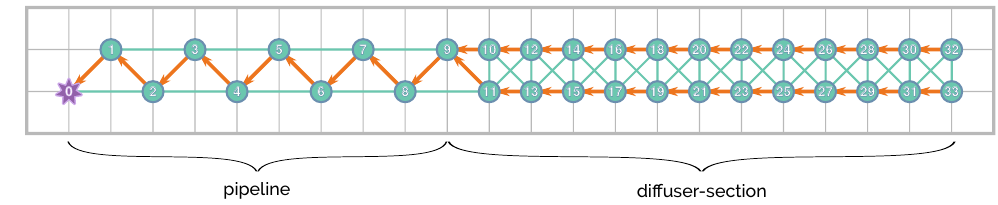
Figure 3. Node distribution—the background grid is 10 m per division. The network follows a zigzag pattern with 10 nodes around the pipeline, from the feeder up to the diffuser section, where a 2 × 12 node mesh is deployed. The zigzag pattern detects leakages along the entire length of the pipe while having a low amount of nodes per unit of distance (compared with the setup around the diffuser section); this pattern also detects leakages on both sides of the pipe, regardless of the direction of the